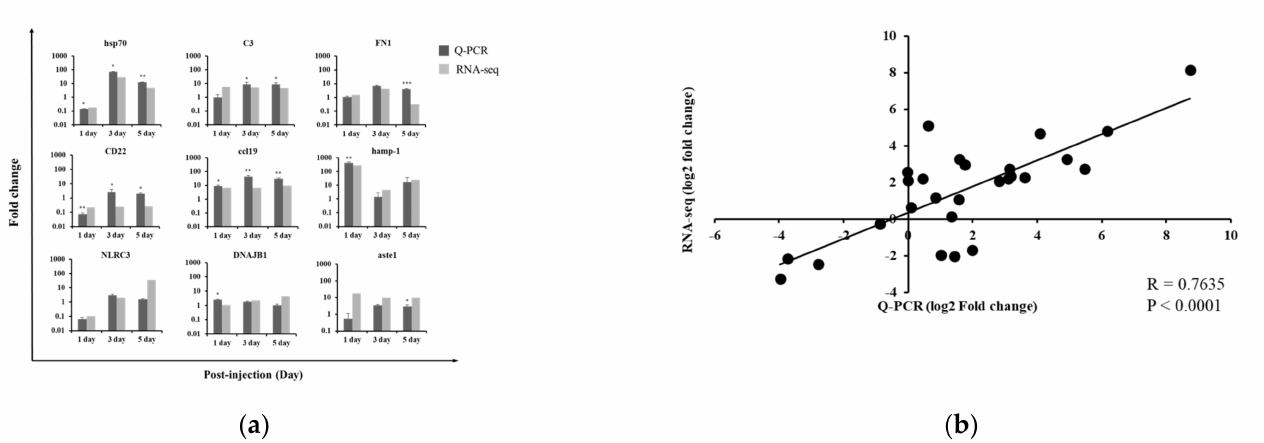
Figure 4. Validation of RNA-seq data. ( a ) Comparison of the fold-change of the expression of nine selected DEGs as determined by Illumina NovaSeq sequencing and Q-PCR. The DEGs were amplified in the head kidney of rainbow trout injected with AV vaccine. EF-1 α was used as an internal reference gene. Data are presented as medians ± SD (n = 8). Asterisks (*) indicate significant differences (* = p < 0.05, ** = p < 0.01, *** = p < 0.001) between the PBS and AV vaccine groups. Hsp70, heat shock protein 70. C3, complement C3; FN1, fibronectin 1; CD22, cluster of differentiation 22; ccl19, C-C motif chemokine ligand 19; hamp-1, hepcidin antimicrobial peptide 1; NLRC3, NLR family CARD domain containing 3; DNAJB1, DnaJ homolog subfamily B member 1; aste1, asteroid homolog 1. ( b ) Correlation analysis of RNA-seq and Q-PCR in gene